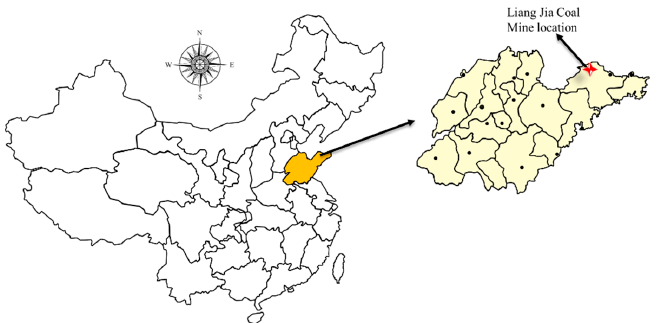
Figure 7. Location of the Liangjia Coal Mine.